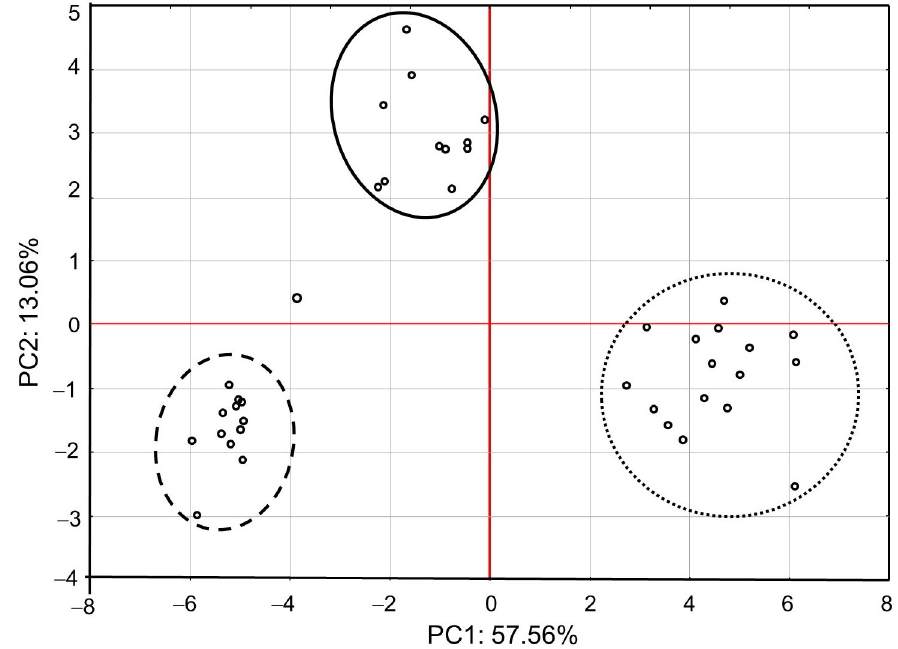
Figure 1. Principal component analysis (PCA) in honey bees exposed and unexposed to imidacloprid: two-dimensional projection of the imidacloprid dose in the principal components PC1 and PC2. Explanations: doted-line ellipse = bees were fed a diet without imidacloprid-control group; solid-line ellipse = bees were fed a diet containing a 5 ppb addition of imidacloprid; dashed-line ellipse = bees were fed a diet with a 200 ppb addition of imidacloprid. Animals 2023 , 13 , x FOR PEER REVIEW